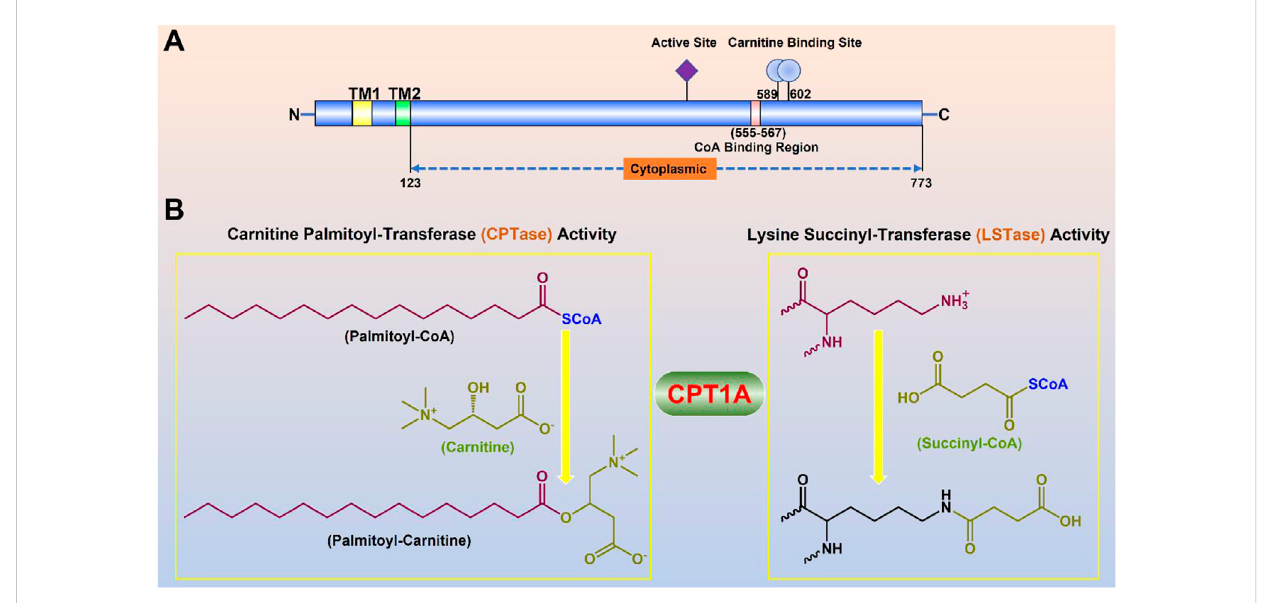
FIGURE 3 Molecular properties and physiological functions of CPT1A. (A) Domain structure of the full-length CPT1A; Two transmembrane helical regions (TM1 and TM2) divide CPT1A protein into the small N-terminal regulatory region (about 47 amnio acids) and the main C-terminal catalytic domain. (B) Dual physiological functions of